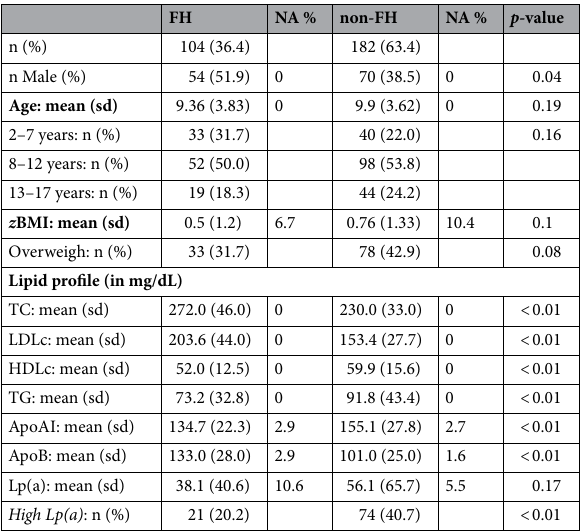
Table 1. Biological and biochemical characteristics of FH and non-FH subjects. FH familial hypercholesterolemia, NA not available, BMI body mass index, TC total cholesterol, LDLc low density lipoprotein cholesterol, HDLc high density lipoprotein cholesterol, TG triglycerides, Apo apolipoprotein, Lp(a) Lipoprotein(a), sd standard deviation.